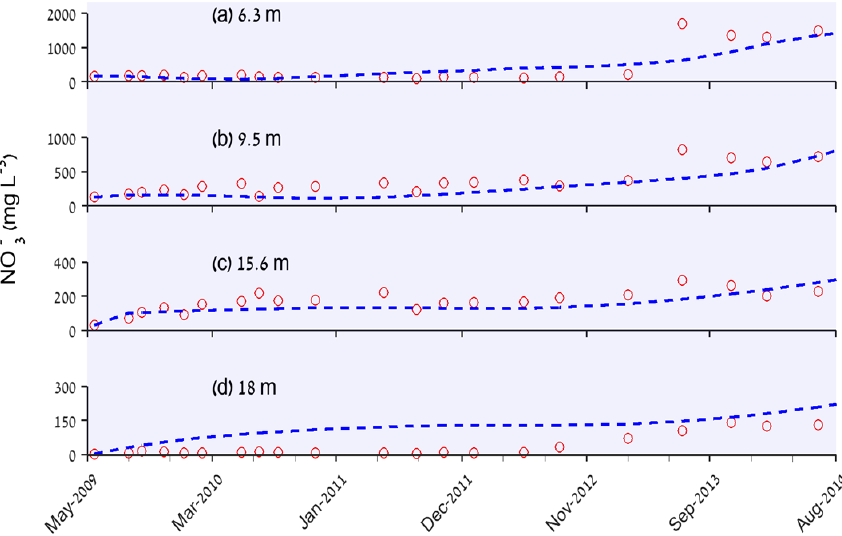
Figure 6. Observed (red dots) and simulated (dashed blue line) nitrate concentrations for the vadose-zone sampling port at the 6.3, 9.5, 15.6 and 18m depths. Nitrate concentration series from each depth served as a multiple-pulse input boundary condition to the consecutive